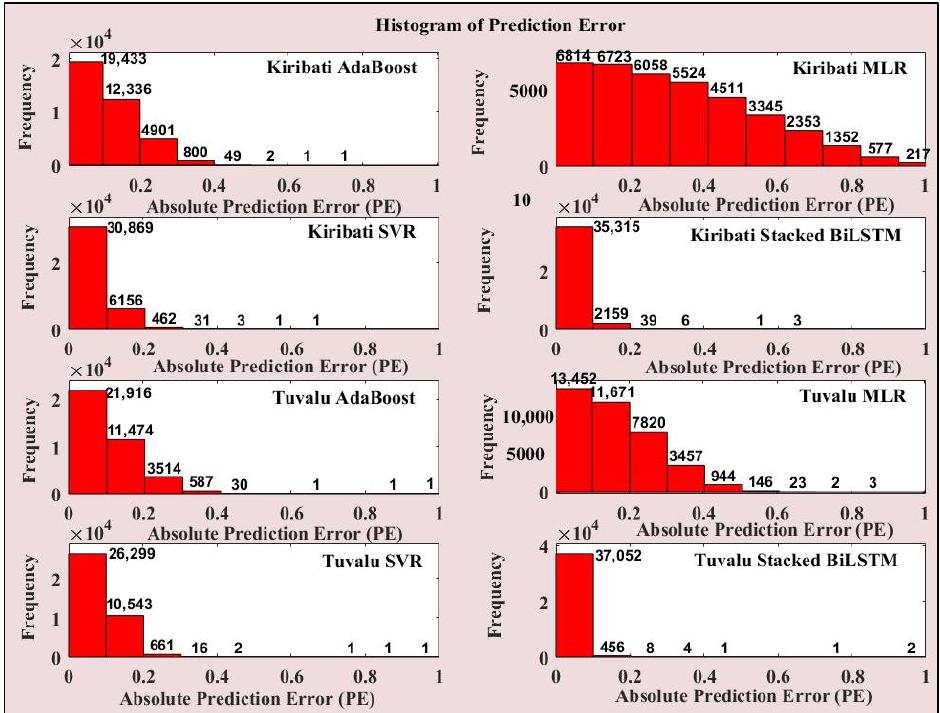
Figure 12. Histogram of absolute prediction error for all models showing the error bins and their frequencies.